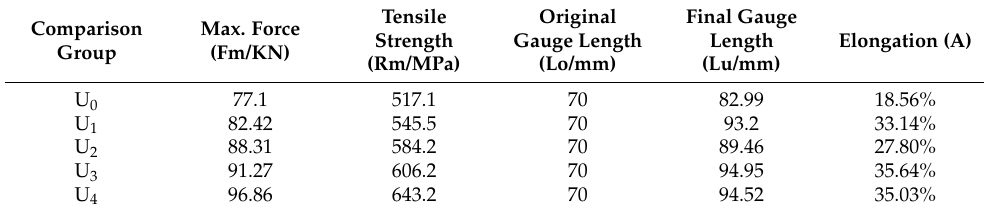
Table 4. Comparison of tensile parameters of samples.